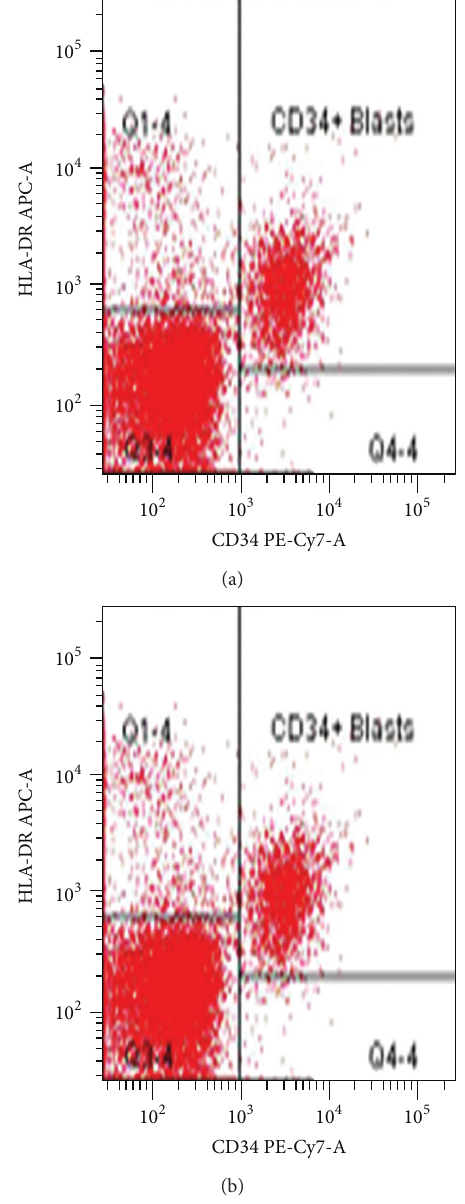
Figure2:(a)Flowcytometryresultsatdiagnosiswithgatingscheme for CD34 versus HLA-DR. (b) Flow cytometry results at diagnosis with gating scheme CD13 versus